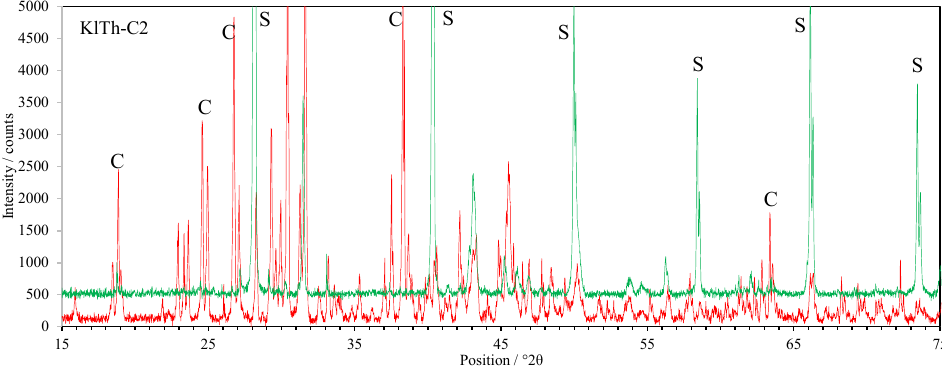
Figure 5. XRD patterns of the carnallite-rich sample K1Th-C2. Shown in red is the pattern of the starting composition at low humidity, shown in green is the final mineral composition at high humidity during the final phase of the experiment. Marked with S and C are some diagnostic peaks for sylvite and carnallite,